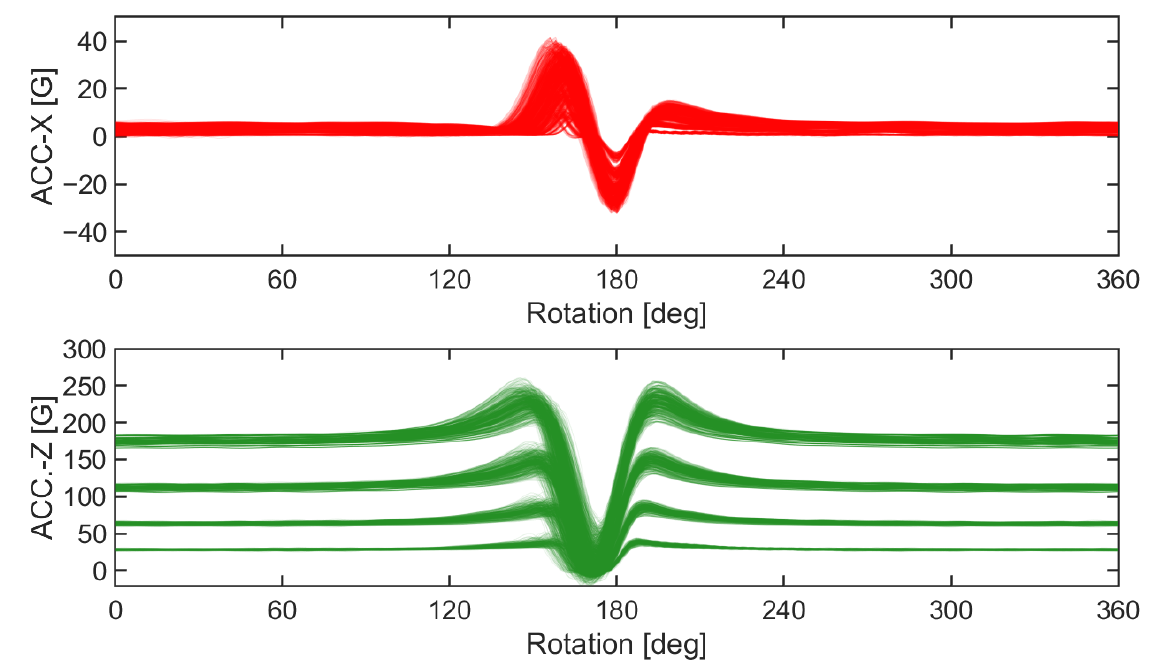
Figure 9. Time histories of circumferential and radial accelerations from tire rolling simulations on the flat road.